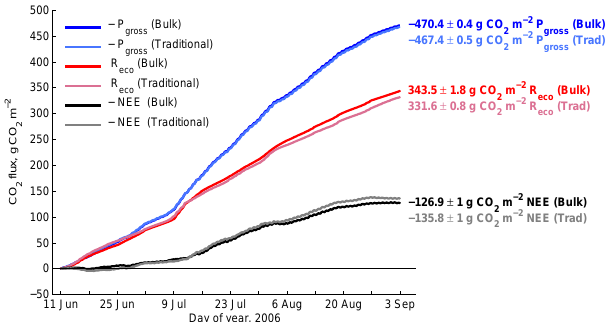
Fig. 6. Cumulative, gap-filled CO 2 fluxes for an 84 day period (11 June–3 September 2006) using different models, where the bulk model is the multi-step approach developed in this paper and the tra- ditional model is also described in the text. Note the sign-switching for P gross and NEE to ease comparison with R eco . Gap-filling was necessary for 21% of the 4032 measurement intervals considered in this period, and creates the differences between the two methods’ cumulative NEE fluxes. Error propagation assumes 20% randomly distributed relative error as 95% confidence intervals on the flux measurements and the derived 95% confidence intervals on the flux partition parameters; these are combined in quadrature (Eq.